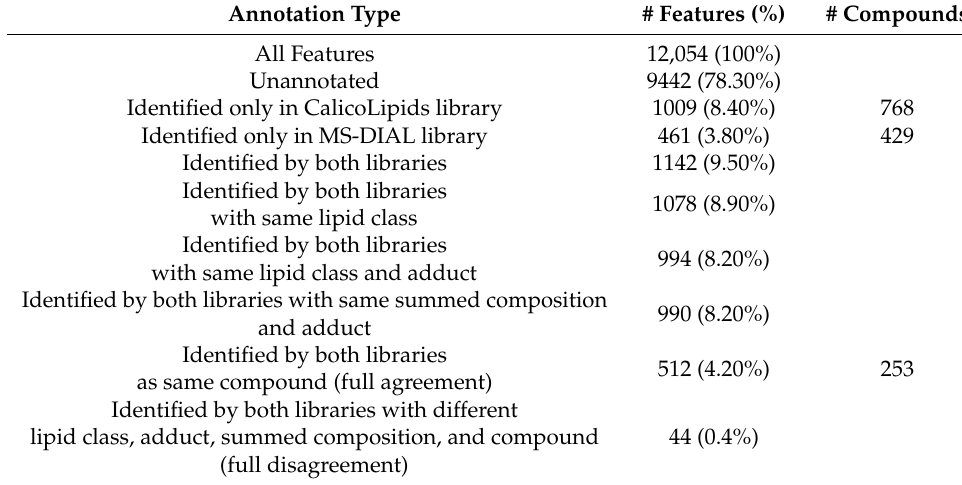
Table 2. Lipid identifications discovered in individual datasets. Two datasets, an internal and